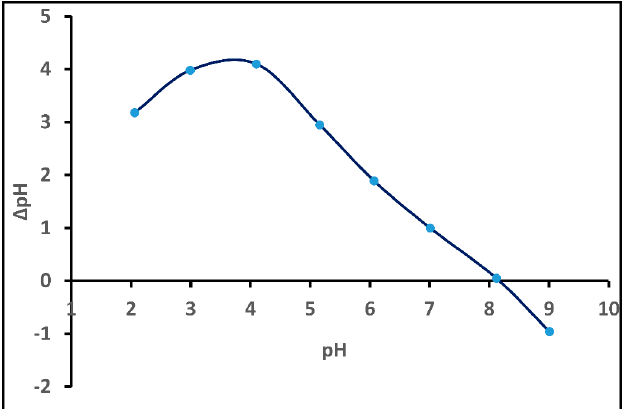
Figure 7. pH PZC of